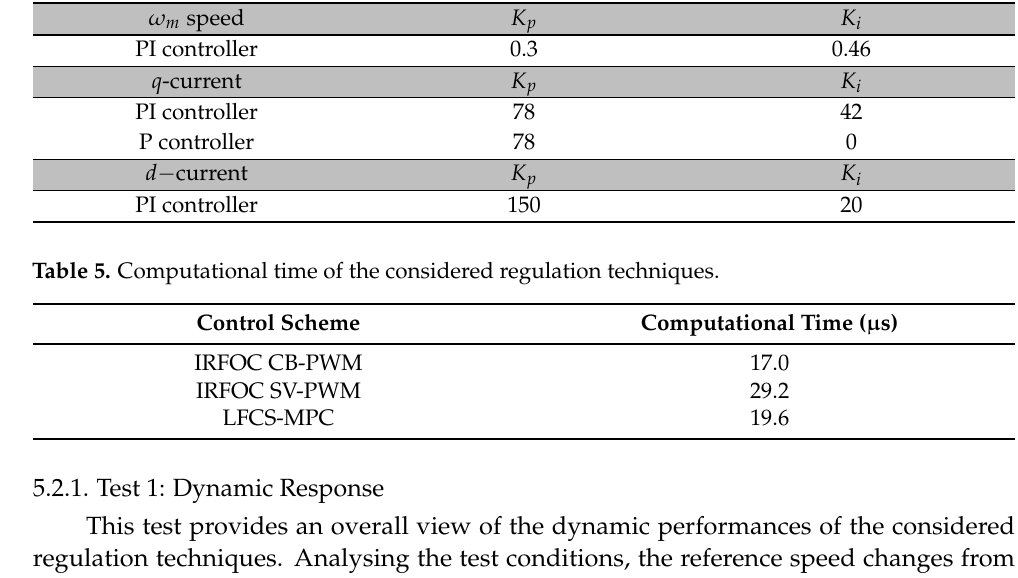
Table 4. Controller parameters for IRFOC SV-PWM.